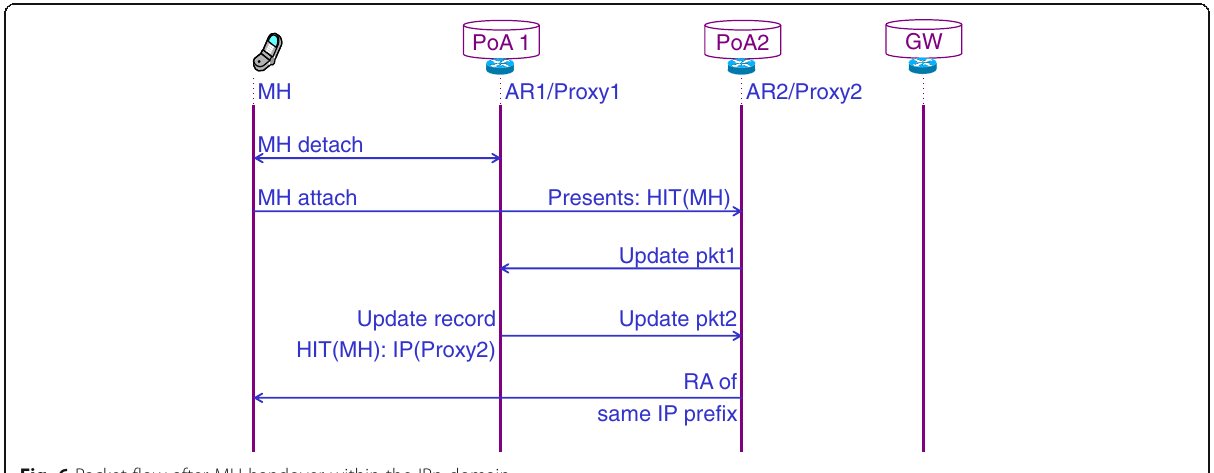
Fig. 6 Packet flow after MH handover within the IPn domain